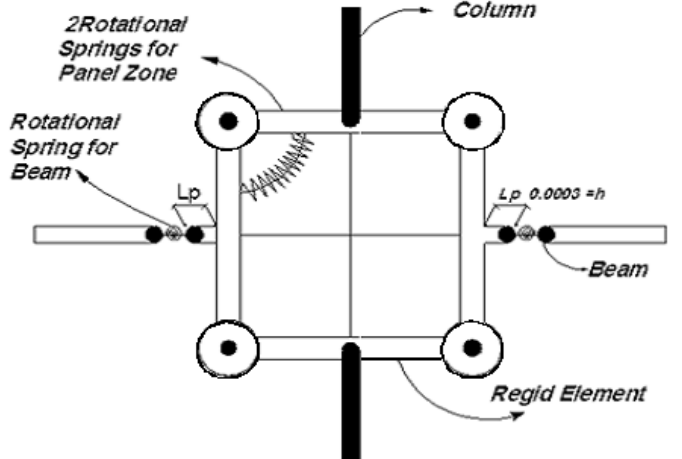
Figure 7. Schematic view of the Panel-Zone element used in modeling simple connections before the Northridge earthquake.